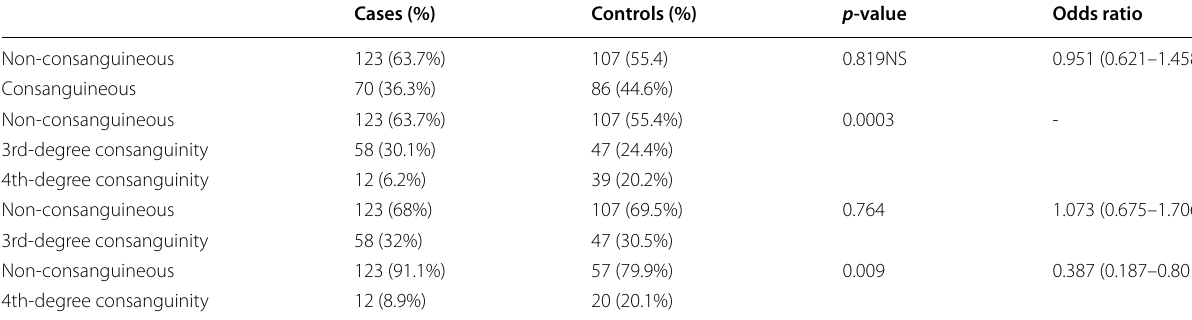
NS , not significant. When comparing cases and controls with having third consanguinity and fourth consanguinity, p indicates that fourth-degree consanguinity was associated with a decreased risk of leukaemia compared to not having consanguinity or to having a third-degree